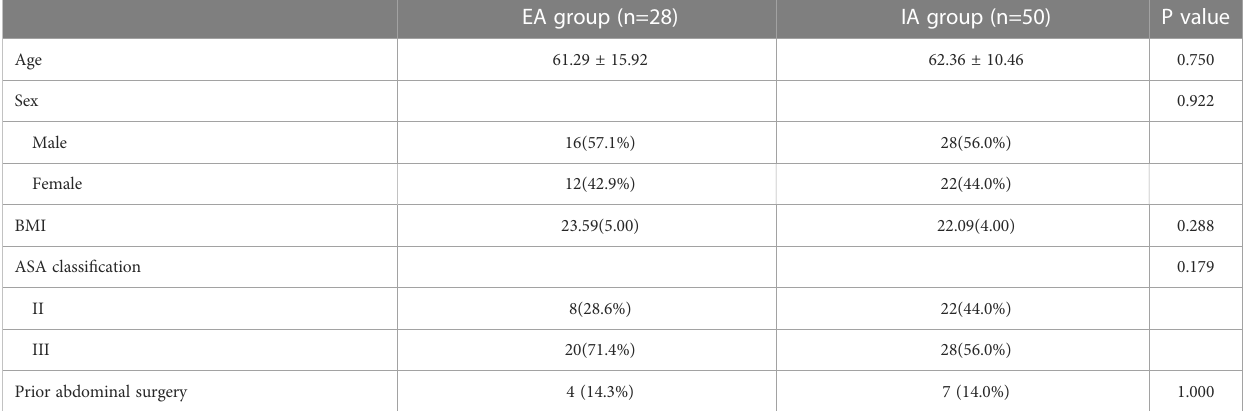
TABLE 1 Baseline clinical characteristics of patients between the extracorporeal anastomosis (EA) group and intracorporeal anastomosis (IA) group.